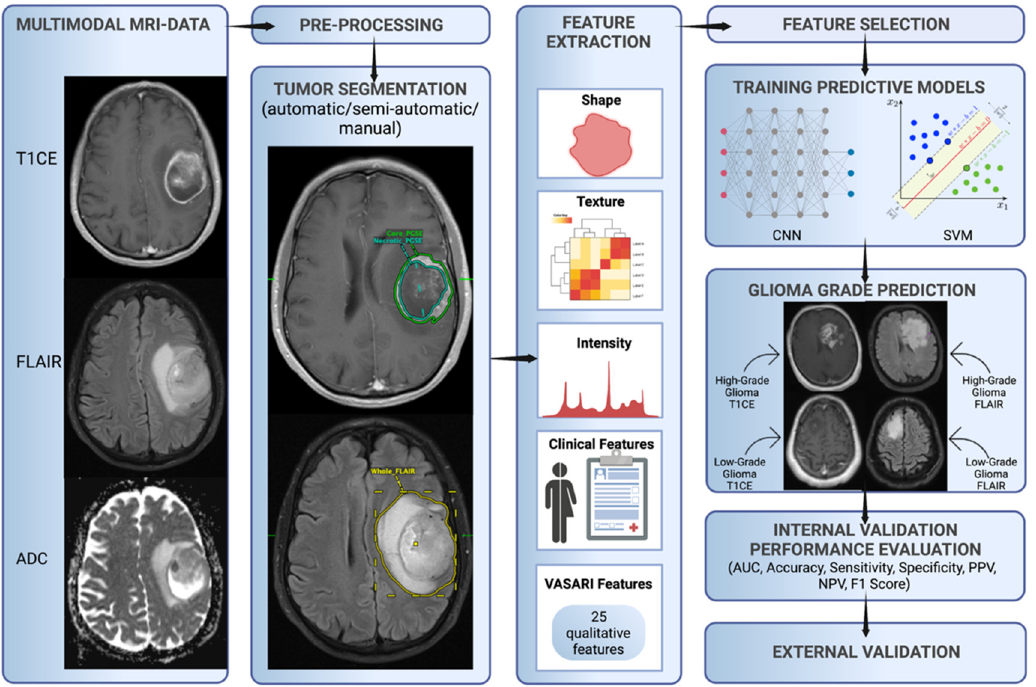
Figure 1. Characteristic workflow for developing ML glioma grade prediction models. VASARI = Visually AcceSAble Rembrandt Images, AUC = area under the curve receiver operating character- istic, CNN = convolutional neural network, ML = machine learning, NPV = negative predictive value, PPV = positive predictive value, and SVM = support vector